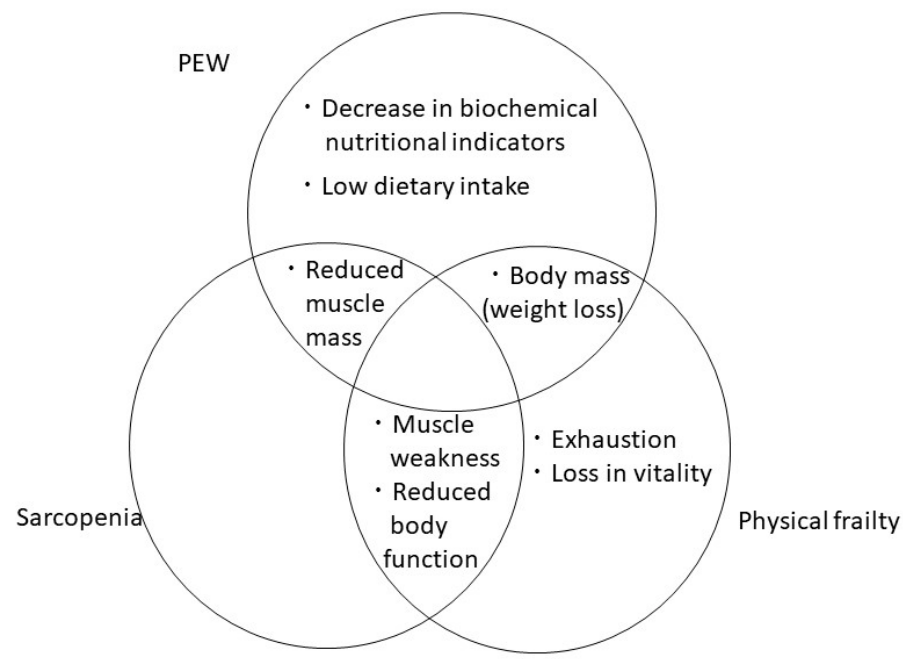
Figure 1. Association between protein-energy wasting (PEW) and sarcopenia and frailty.